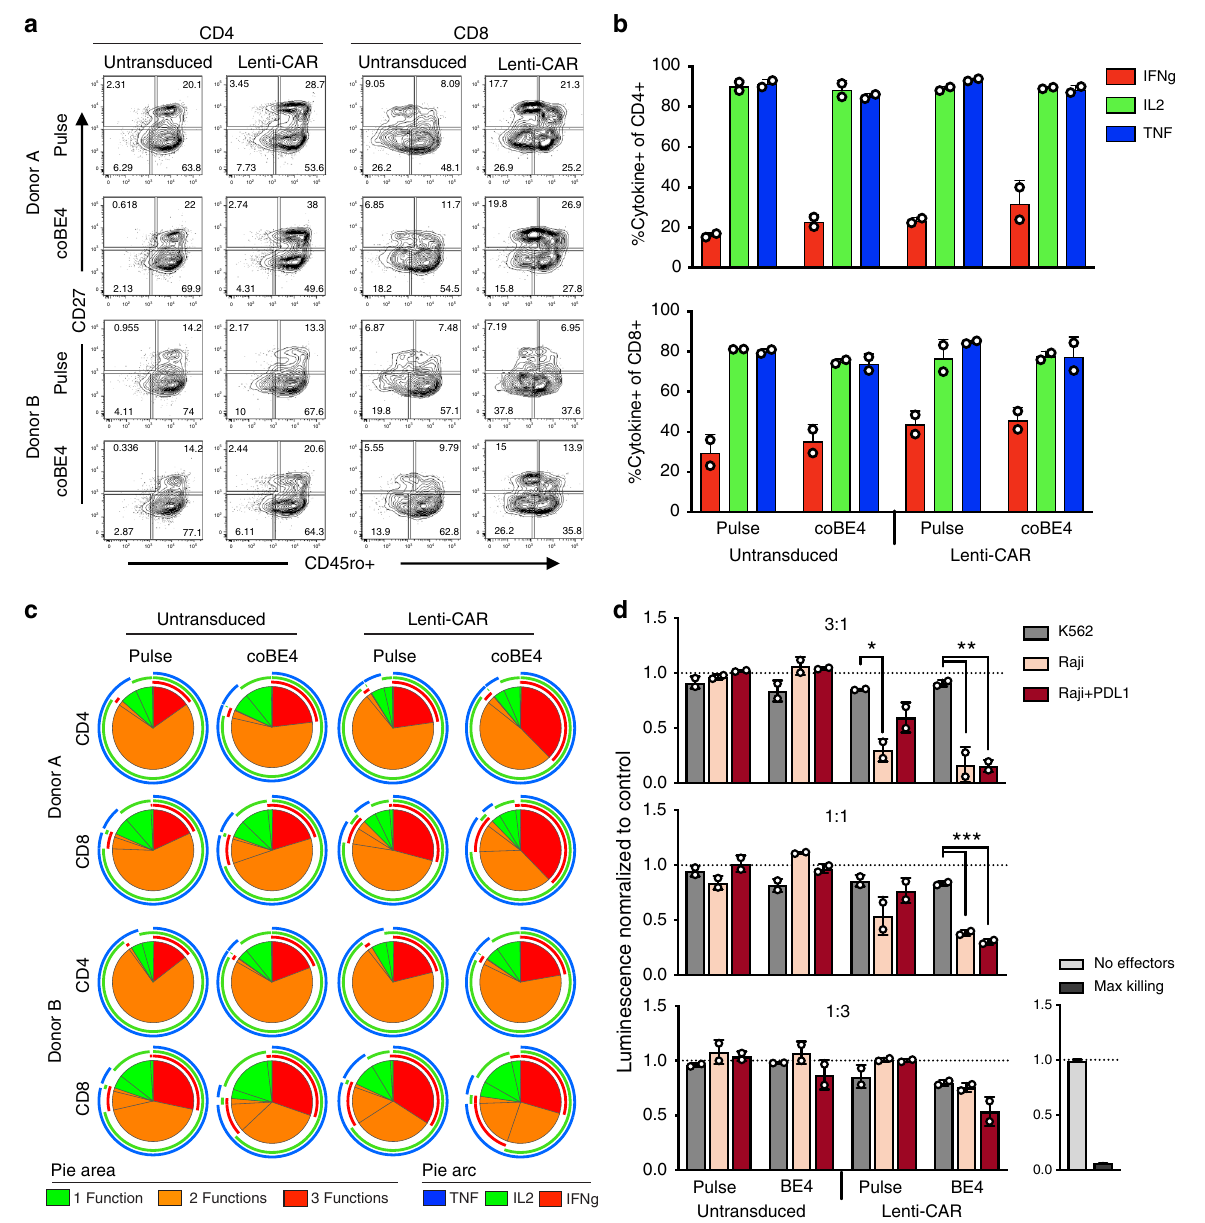
Fig. 4 Function of multiplex edited T cells. a Expression of the memory marker CD27 and CD45ro following editing and expansion. Production of cytokines individually ( b ) and in combination ( c ) by CD4 and CD8 T cells following activation. d Ability of T cells to kill CD19 neg K562, CD19 pos Raji cells, or CD19 pos/ PD-L1 pos Raji cells as measured by luciferase luminescence assay following co-culture with T cells. Graph titles indicate E:T ratio. Data represented as mean ± SD, with assays run in triplicate in n = 2 independent biological T-cell donors. P -values calculated by the Student ’ s paired two-tailed t test (n.s. P > 0.05, * P ≤ 0.05, ** P ≤ 0.01, *** P ≤ 0.001, **** P ≤